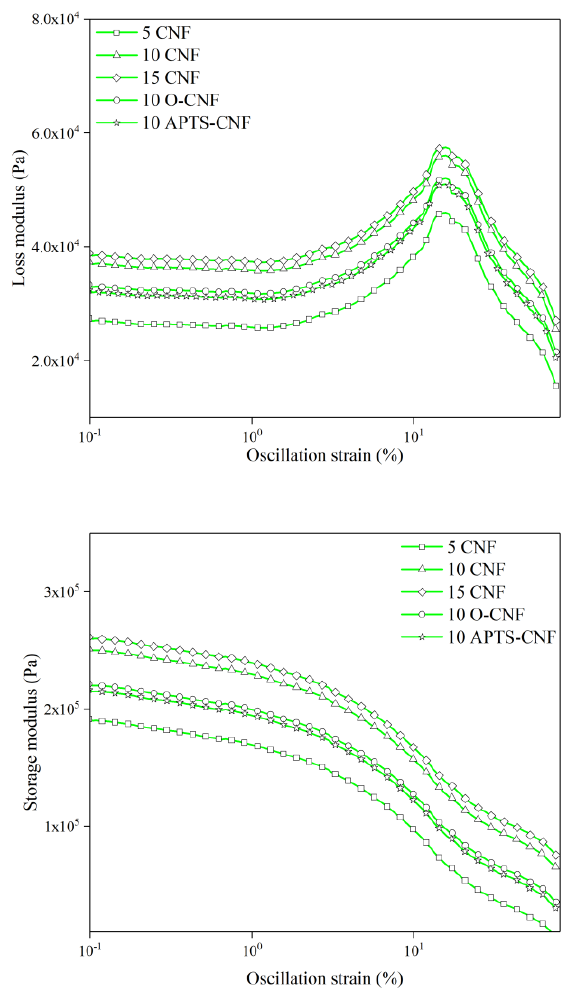
Figure 13. Dynamic moduli of NBR filled with carbon nanofibers as a function of oscillation strain. Table 2. Dynamic measurements data.